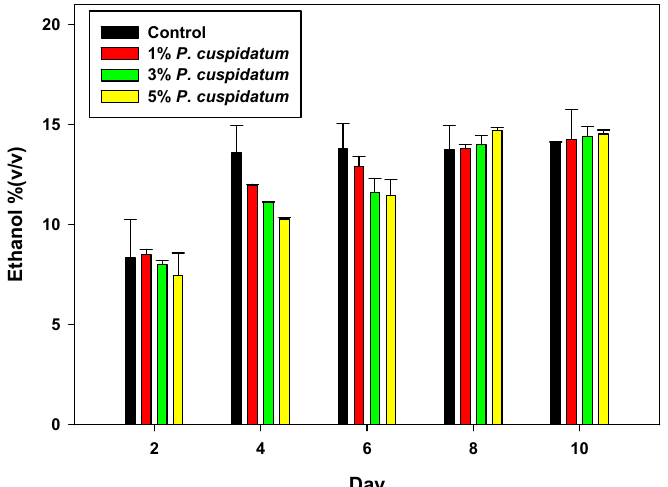
Figure 2. Effect of P. cuspidatum roots on ethanol yield during rice wine fermentation. Control was performed without the addition of P. cuspidatum .